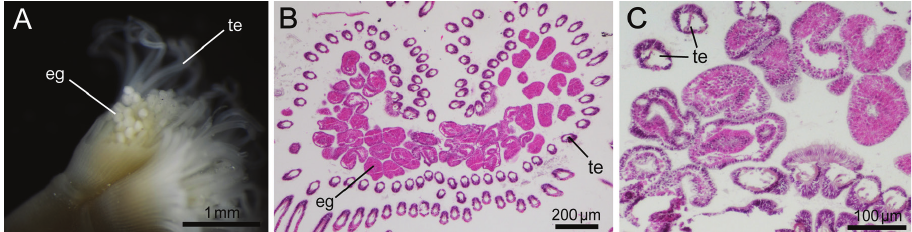
Figure 7. Phoronis ijimai . A NSMT-Te 878, eggs brooded in the lophophore (some tentacles have been removed) B NSMT-Te 884, transverse section through the basal part of the lophophore, showing mature eggs on the basal nidamental glands C NSMT-Te 883, enlargement of brooded eggs, showing various developmental stages. Abbreviations: eg egg; te